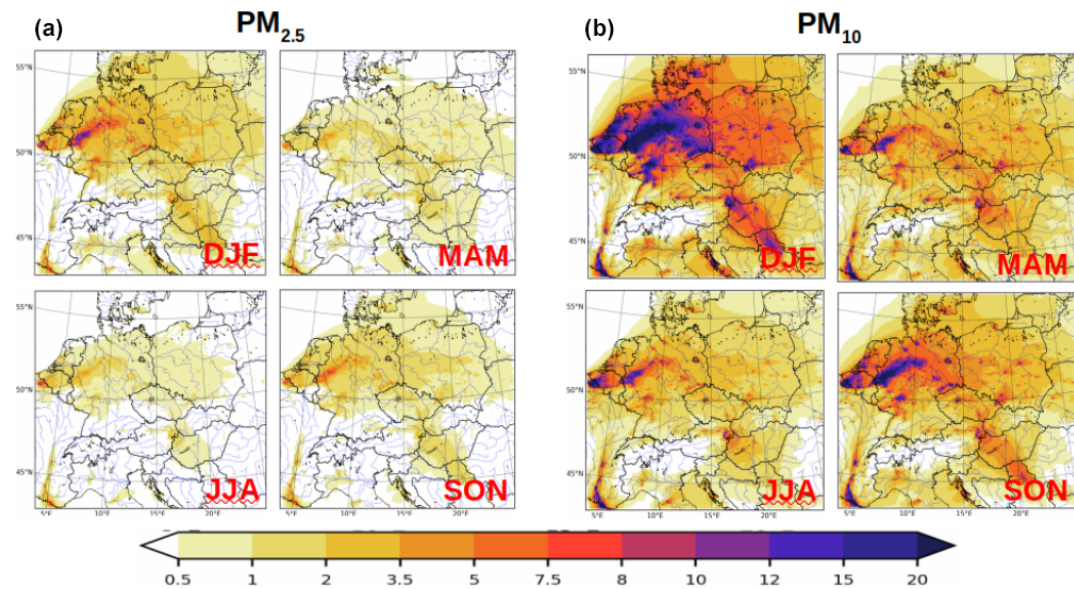
Figure 19. Seasonally averaged impact of WBD emissions on PM 2 . 5 (a) and PM 10 (b) concentrations in micrograms per cubic metre for 2007–2016.